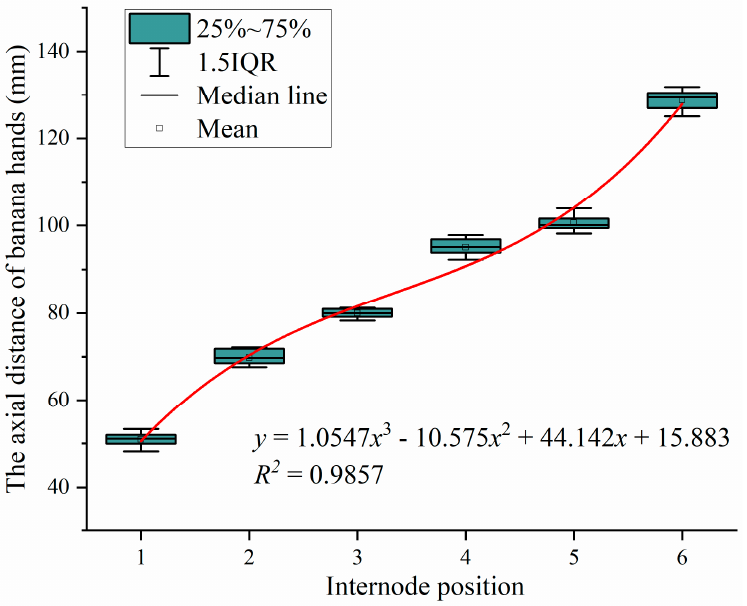
Figure 18. The relationship between the axial distance of banana hands and the internode posi- tions.